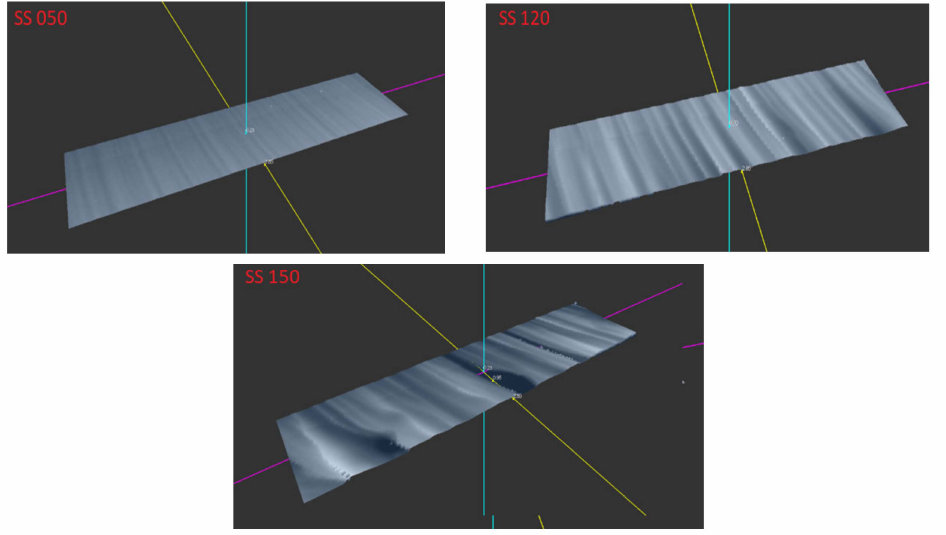
Figure 12. 3D model of the scanned A304